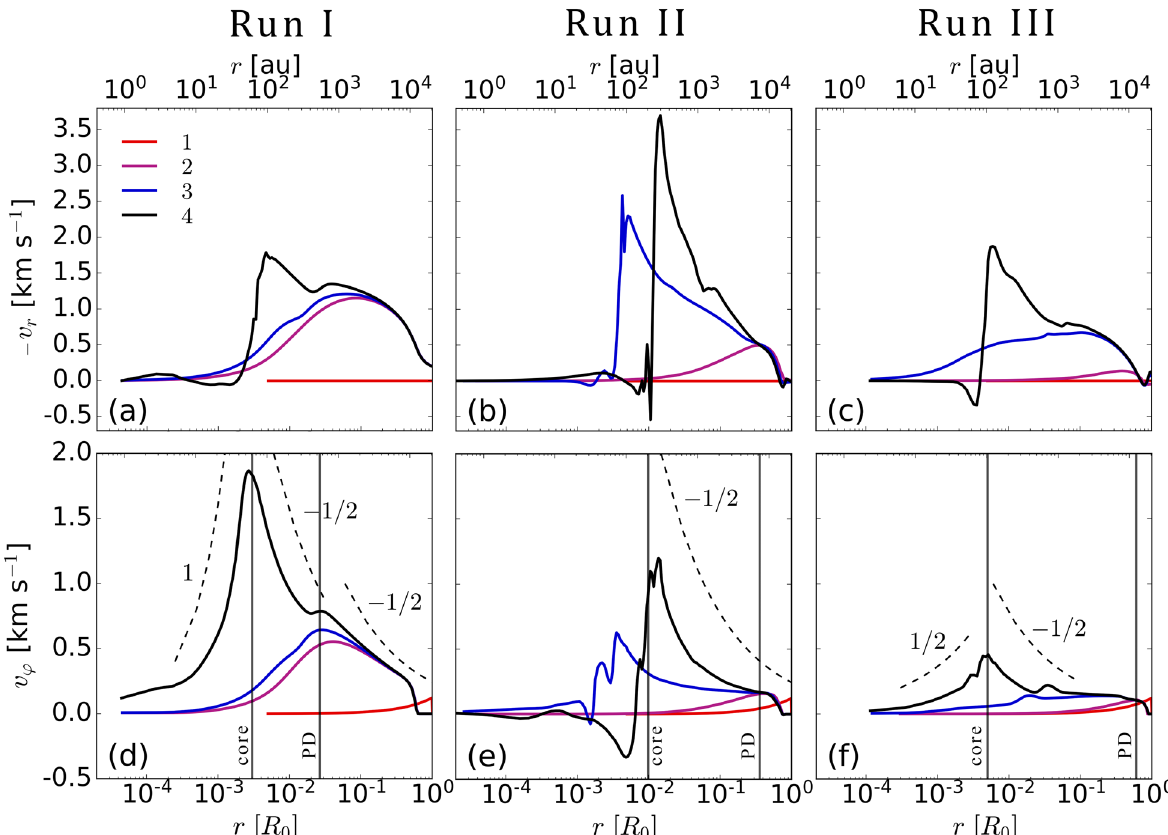
Figure 3: Pro fi les of radial velocity ( v − r ) and azimuthal velocity v φ along the equatorial plane for runs with weak ( run I, the fi rst column ) , moderate ( run II, the second column ) , and strong ( run III, the third column ) magnetic fi elds at di ff erent moments of time. Line 1 ( red color ) : start of the collapse. Line 2 ( pink color ) : the moment of primary disc formation corresponding to Figure 2 ( a, e, i ) . Line 3 ( blue color ) : the moment of the fi rst core formation corresponding to the Figure 2 ( c, f, k ) . Line 4 ( black color ) : the end of the simulation corresponding to Figure 2 ( d, h, l ) . Dashed lines with numbers show characteristic slopes. Vertical lines show the boundaries of the fi rst core and primary disk at the end of the